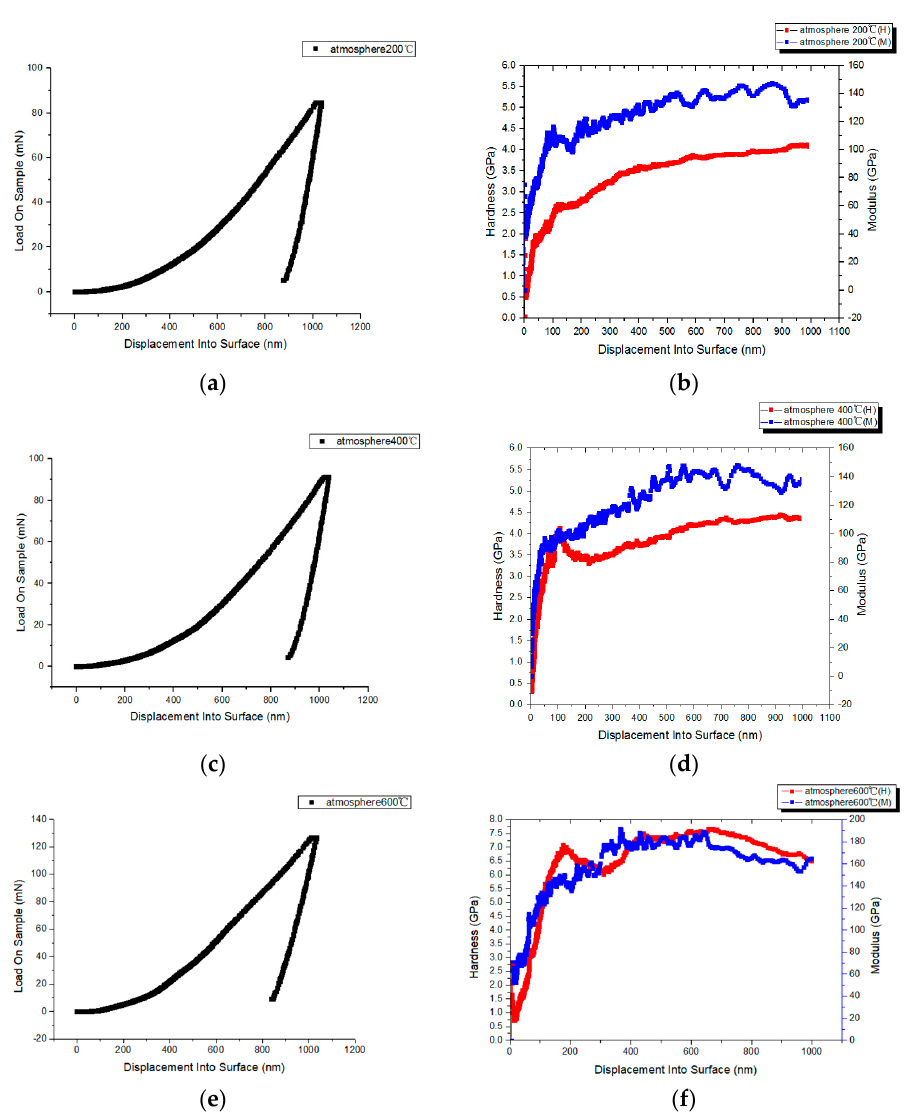
Figure 11. Characteristic load vs. nanoindentation depth for anodized samples annealed in atmosphere at ( a ) 200 °C, ( c ) 400 °C and ( e ) 600 °C. Hardness and modulus vs. nanoindentation depth for anodized samples annealed in air at ( b ) 200 °C, ( d ) 400 °C, and ( f ) 600 °C.